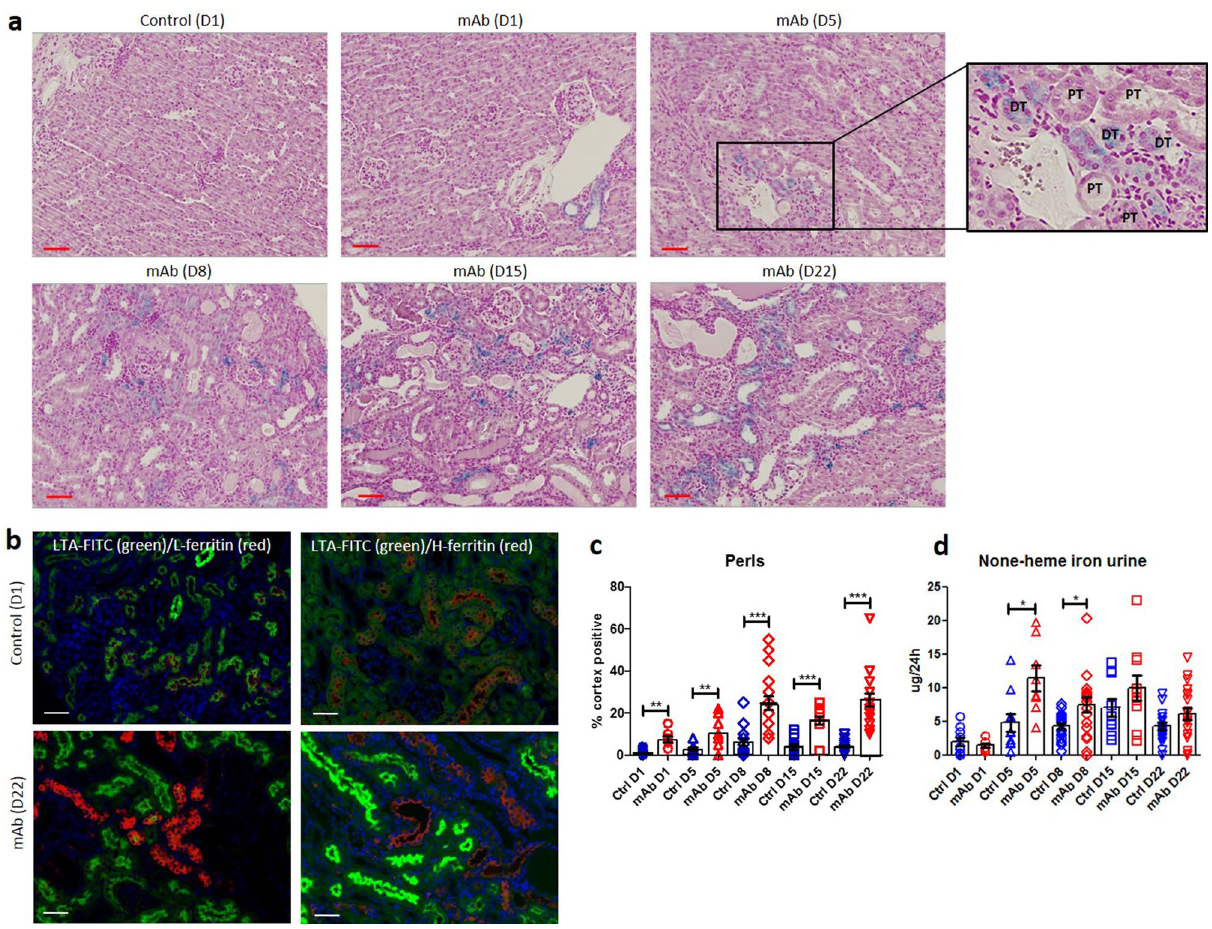
Figure 2. Kidney iron loading in mAb-injected mice. Representative images of kidney Perls staining demonstrating iron deposition (in blue) in mAb-injected mice that increases over time ( a ). Immunostaining of L-ferritin and H-ferritin in combination with proximal tubule marker LTA-FITC demonstrates distal tubule iron deposition ( b ). Quantification of kidney iron loading as a percentage of cortex tubules